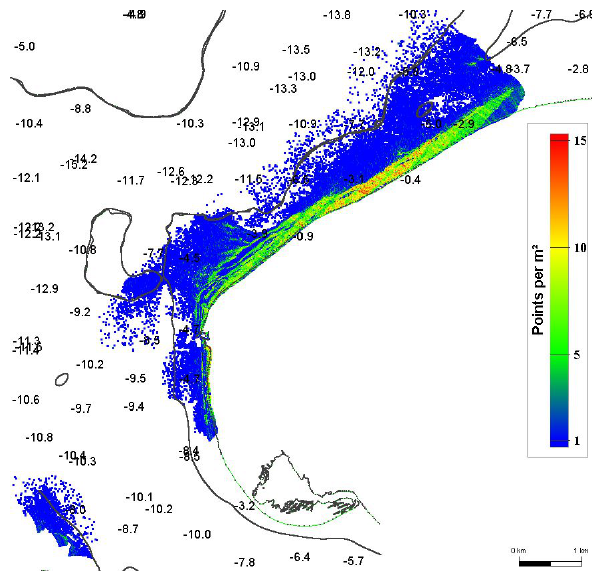
Figure 8: Area 4 - point densities (points per square meter) of the sea bed points (with 5m isobath).